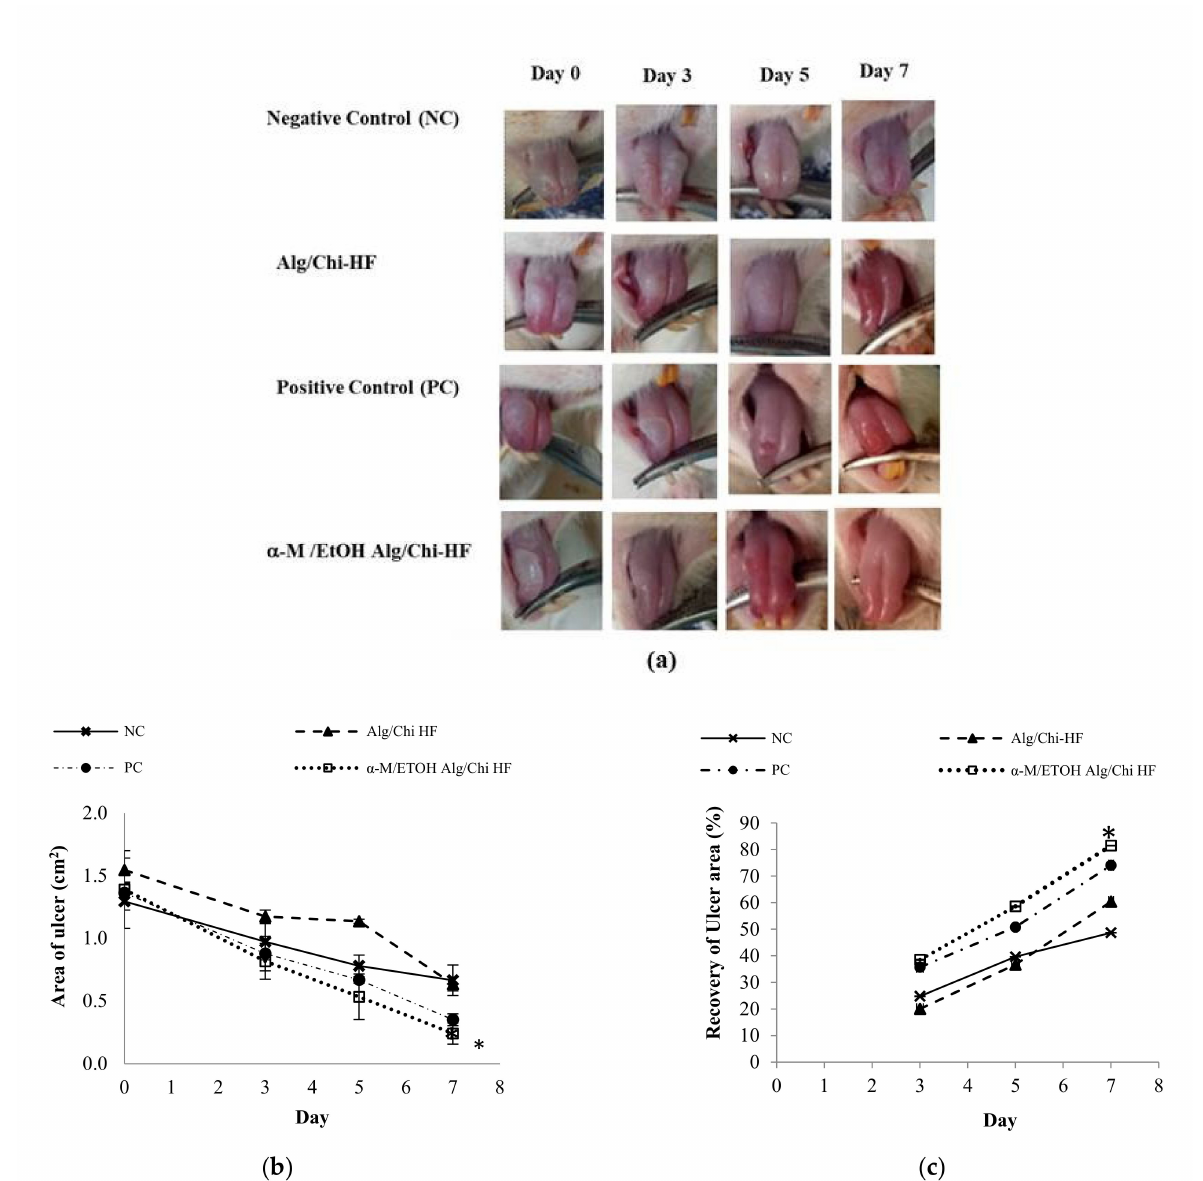
Figure 8. In vivo wound-healing study of a-M/EtOH Alg/Chi-HF ( a ). The decrease in ulcer area ( b ). The percentage recovery of ulcer area ( c ). Each value represents the mean ± SD of three experiments. On the 7th day, * p < 0.05, compared to the NC and Alg/Chi